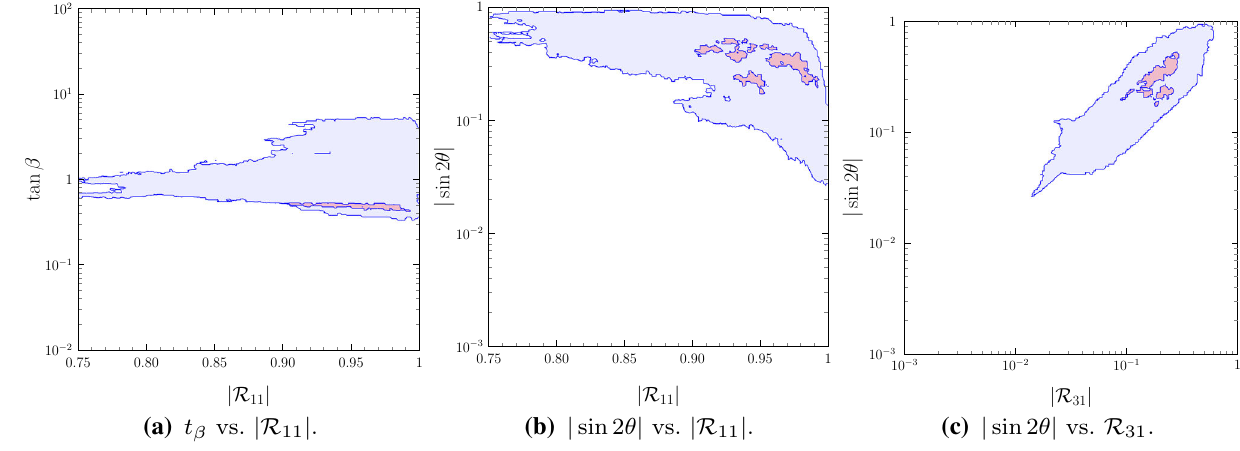
(b) | sin 2 θ | vs. |R 11 | . (c) | sin 2 θ | vs. R 31 . Fig. 9 Regions allowed at 99% CL by the requirements of the full analysis (see Fig. 6)